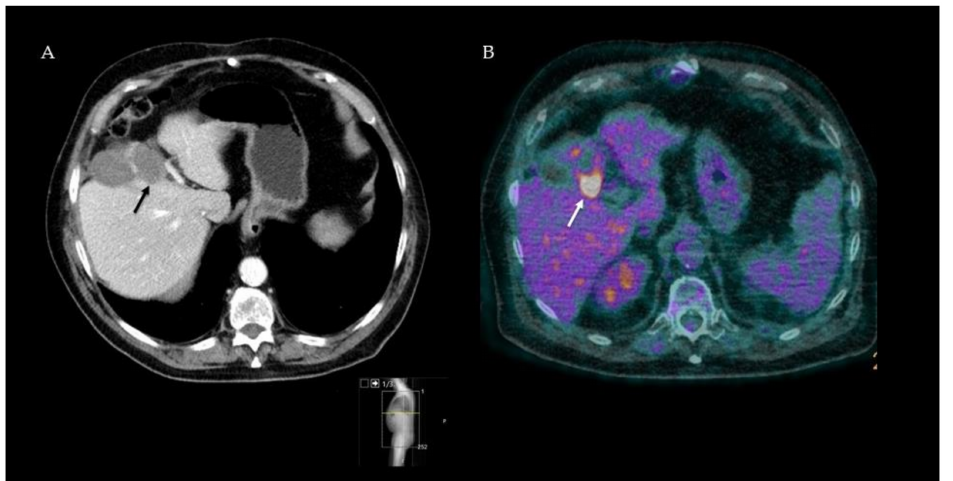
Figure 2. Follow-up ceCT image three months after RFA, suggesting clear ablation margins (black arrow) and no residual tumor ( A ). Simultaneous 18 F-FDG-PET-CT image of the same patient showing high focal FDG uptake in the tumor periphery (white arrow) strongly suspected of residual disease ( B ). Three months later, CEA levels had risen, and the focal FDG uptake had spread, confirming tumor residue at the ablation